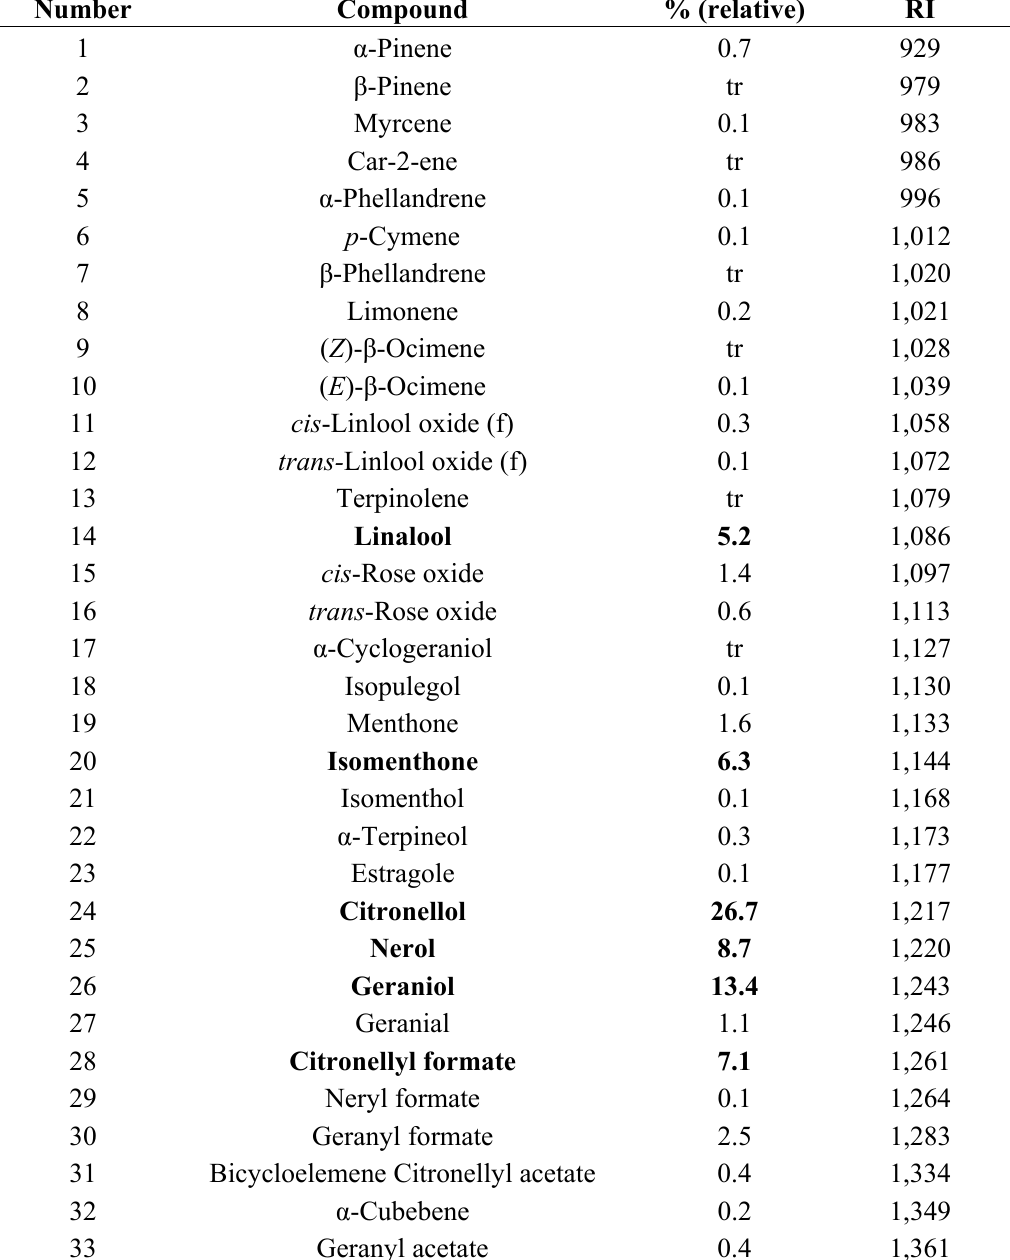
Table 1. Chemical composition of geranium oil of Pelargonium graveolens